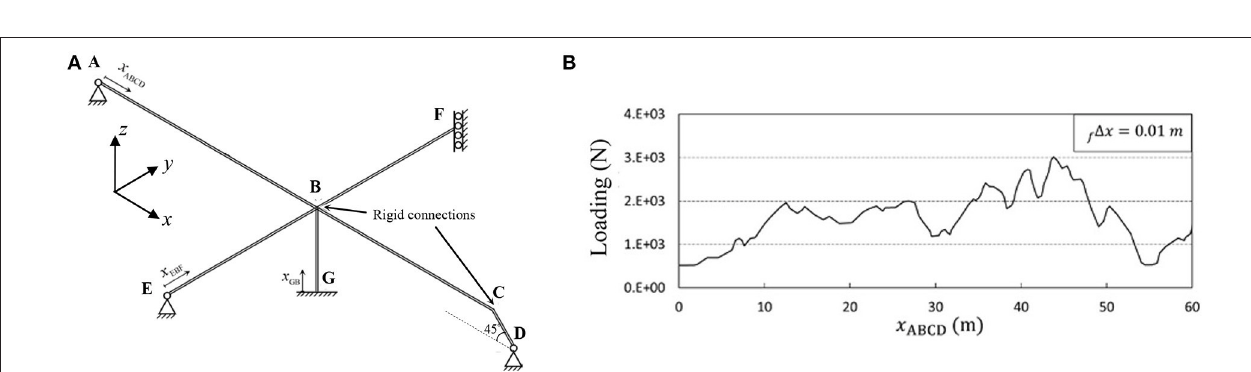
Frontiers in Built Environment |